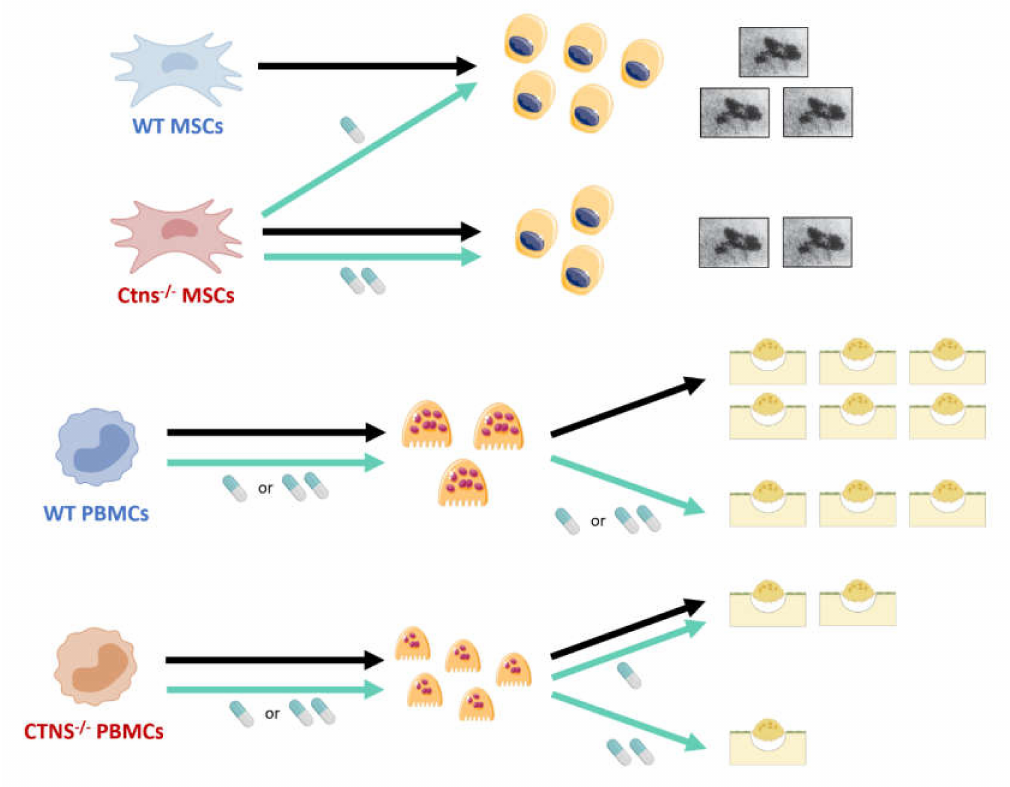
Figure 1. Current understanding of osteoblastic and osteoclastic defects in cystinosis, resulting from a combination of cystinosin deficiency and cysteamine e ff ects. Mesenchymal stem cells (MSCs) isolated from a patient with cystinosis display a reduced ability to di ff erentiate into osteoblasts, which can be reverted after cysteamine treatment. In vitro mineralization assays demonstrate a reduced ability to release mineralized nodules from cystinotic osteoblasts as compared to control cells. In vitro low doses of cysteamine (50 µ M) stimulate osteoblastic di ff erentiation and mineralization, with an inhibitory e ff ect at higher doses (200 µ M). Cystinosis favors osteoclastogenesis, mononuclear progenitors being more prone to generate osteoclasts than controls. Cysteamine has no e ff ect on osteoclastic di ff erentiation whatever the origin of the donors and the doses tested. However, it is noteworthy that cysteamine displays a beneficial anti-resorptive e ff ect: in controls, a 50%-inhibition of resorption activity is observed with 50 µ M. As for patients, the decreased osteoclastic activity is detectable and significant only at 200 µ M. WT, Wild-type; Ctns - / - , gene knockout (murine model); CTNS - / - , cystinotic patients; MSC, Mesenchymal stem cell; PBMC, Peripheral blood mononuclear cell. Black arrow: no treatment; Blue arrow: cysteamine treatment. Pill icon: cysteamine - 50 µ M (one pill), 200 µ M (two pills). Top right pictures: mineralization nodules magnification (Von Kossa staining); Bottom right illustrations: osteoclastic resorption